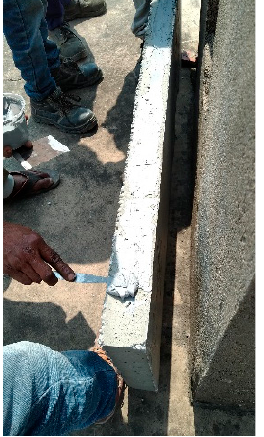
Figure 14. Application of grouting material.